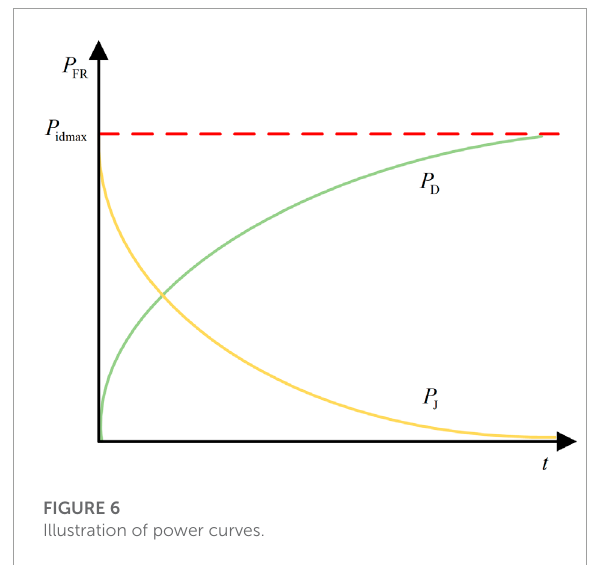
FIGURE 6 Illustration of power